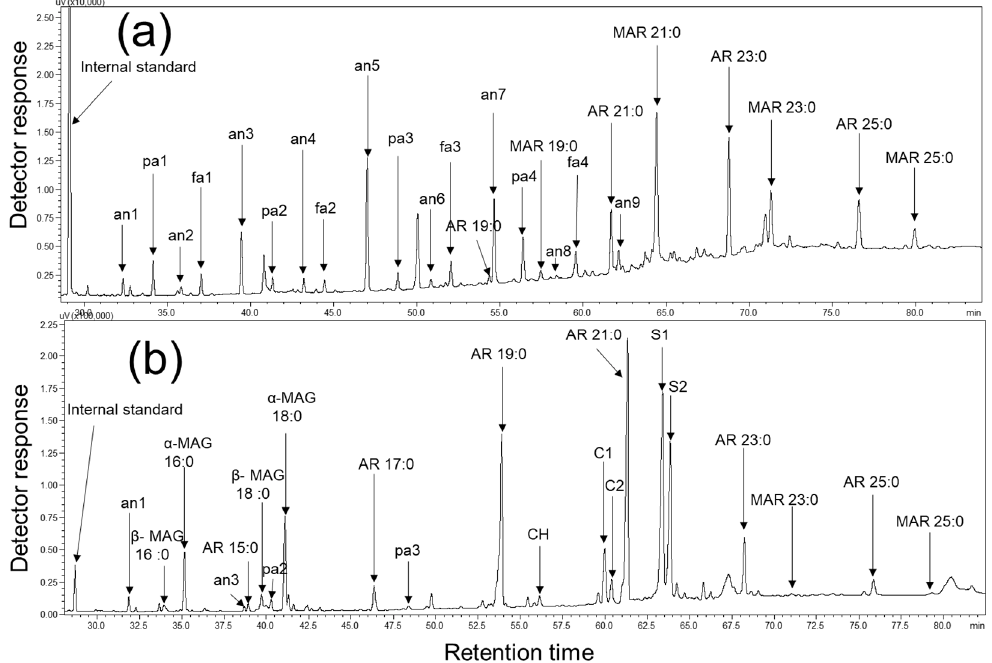
Figure 2. GC chromatogram of SSL ( a ) and WGL ( b ) of Houdemai 981 (HDM981). Internal standard, tetracosane (C24); AR(n): n-alkylresorcinols; MAG(n): n-monoacylglycerols; MAR(n): n-methylalkylresorcinols; n denotes the carbon atom number. Other compounds reflected are as follows: an1, pentacosane; an2, hexacosane; an3, heptacosane; an4, octacosane; an5, nonacosane; an6, triacontane; an7, hentriacontane; an8, dotriacontane; an9, tritriacontane; pa1, docosanol; pa2, tetracosanol; pa3, hexacosanol; pa4, octacosanol; fa1, docosanoic acid; fa2, tetracosanoic acid; fa3, hexacosanoic acid; fa4, octacosanoic acid; CH, cholesterol; C1, campesterol; C2, campestanol; S1, sitosterol; S2, sitostanol.